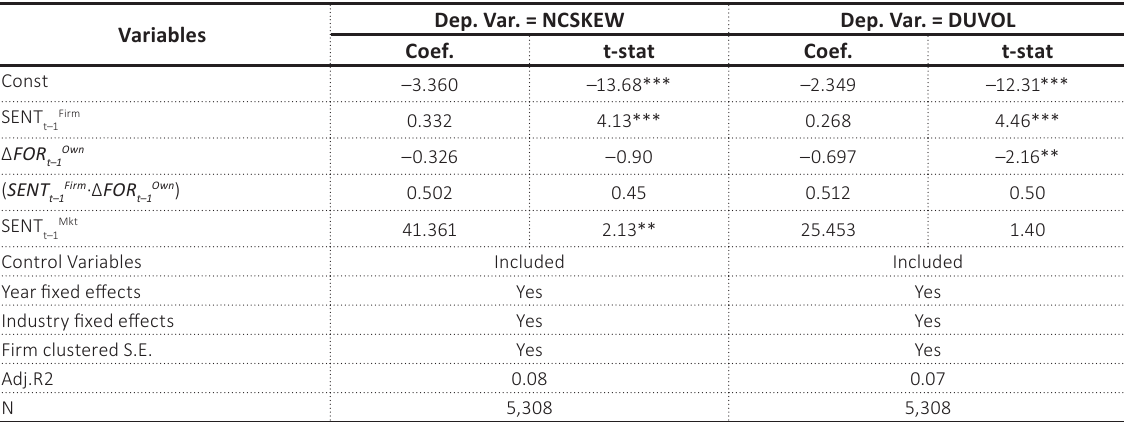
Table 4. Additional test: The role of foreign investor (foreign ownership